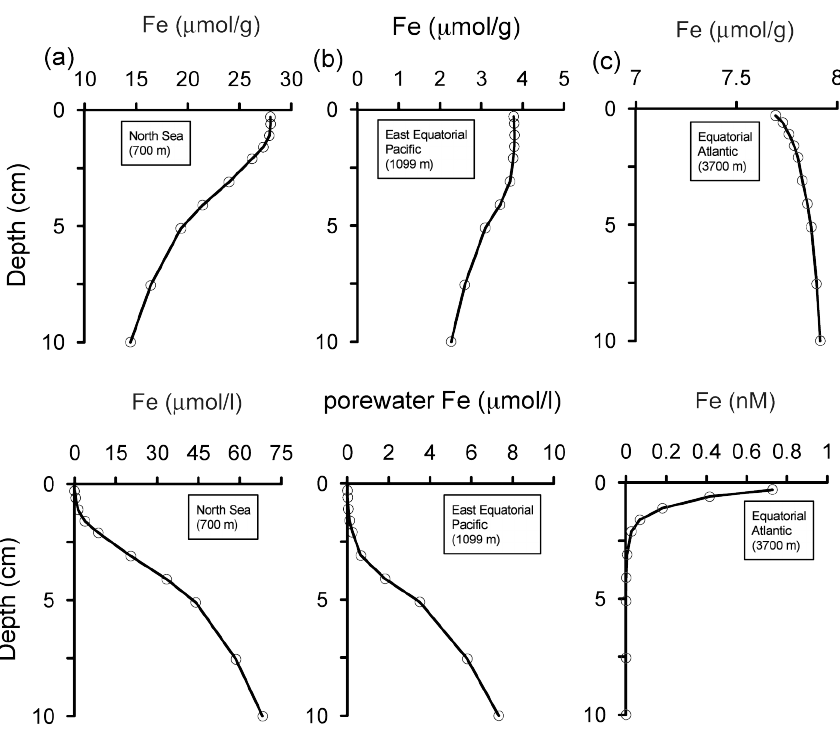
Fig. 3. Vertical profiles of Fe oxides and porewater Fe in the sediment-bioturbated layer at three different locations, as simulated in the model reference